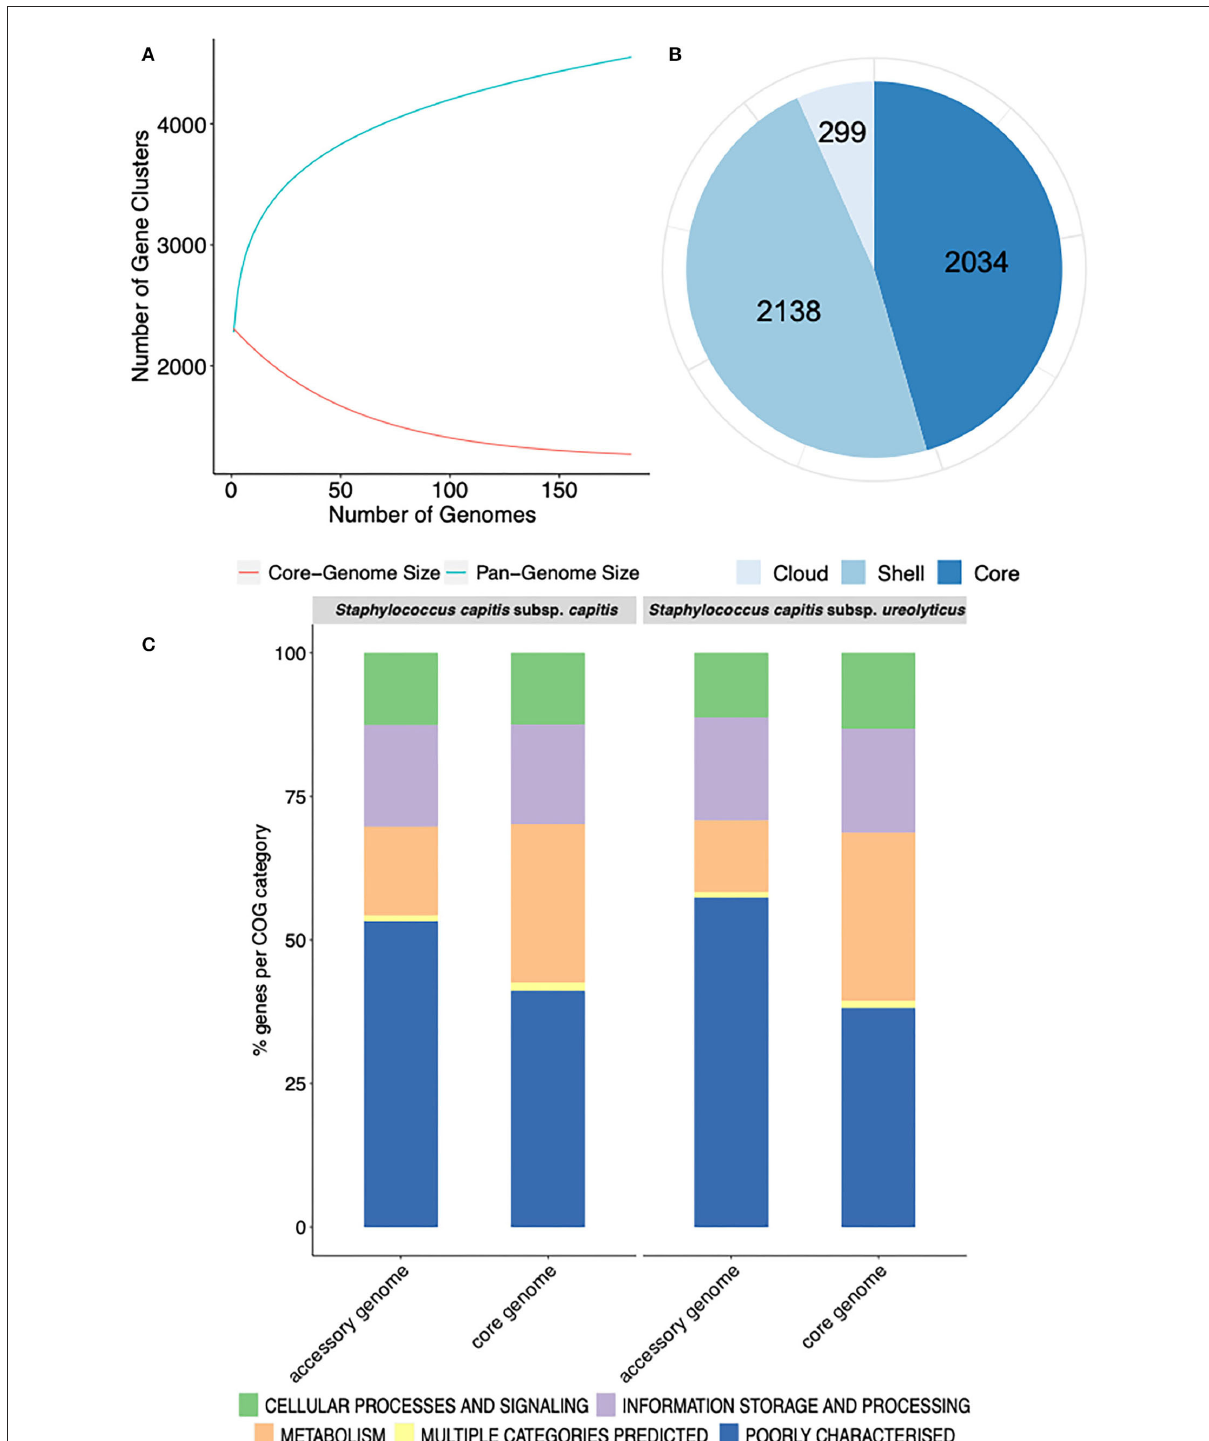
FIGURE1 Representation of the pan-genome and COG functional annotation of S. capitis genomes. (A) Pan-genome curve generated by plotting the total number of gene families in the pan (blue) and core (red) genome of S. capitis. The graph represents how the pan- and core-genomes vary as genomes are added in random order. As the number of genomes increased, the pan-genome increased. (B) Staphylococcus capitis pan-genome statistics. The size of the pan-genome, including core (shared by > 95% of isolates), shell (found in 15–95% of isolates), and cloud (found in < 15% of isolates) genes. (C) Functional annotation of the core and accessory genomes of S. capitis subsp. capitis and S. capitis subsp. ureolyticus . Percentages of the core and accessory genomes annotated according to COG functional